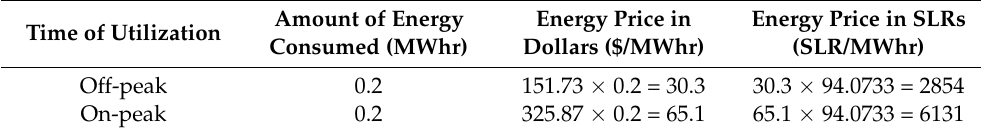
Table 2. The implemented energy price mechanism.